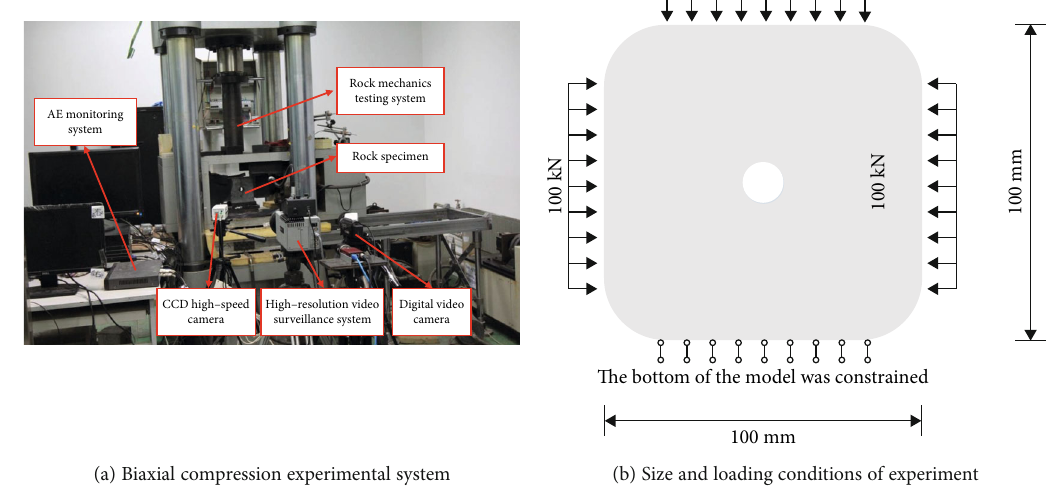
Figure 2: Biaxial compression experiment using AE